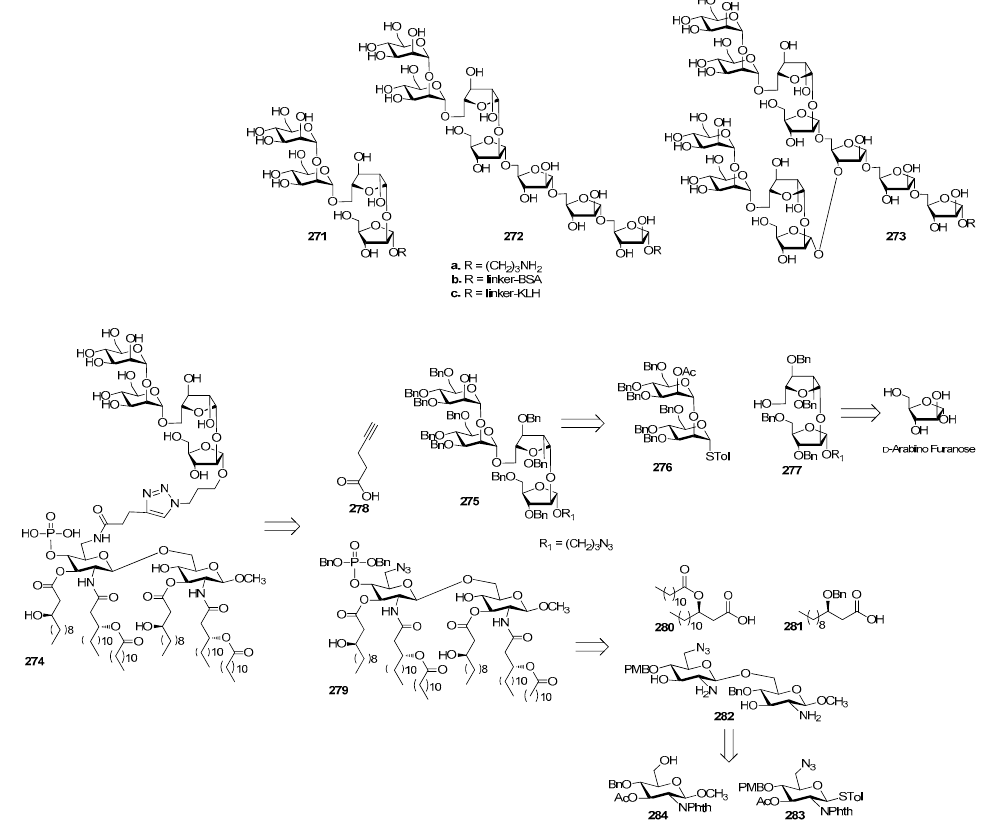
Figure 29. LAM oligosaccharides reported in Reference [83] and retrosynthetic route to LAM tetrasaccharide coupled to a monophosphoryl lipid A (MPLA), as reported in [226].